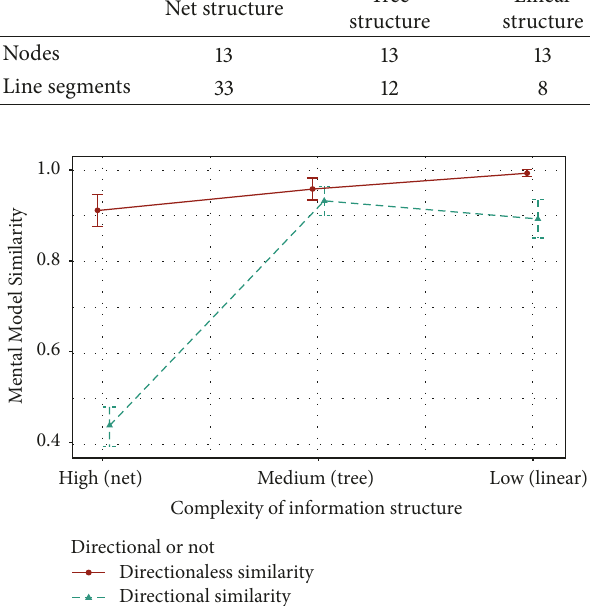
Figure 5: The influence of complexity of information structures on mental model